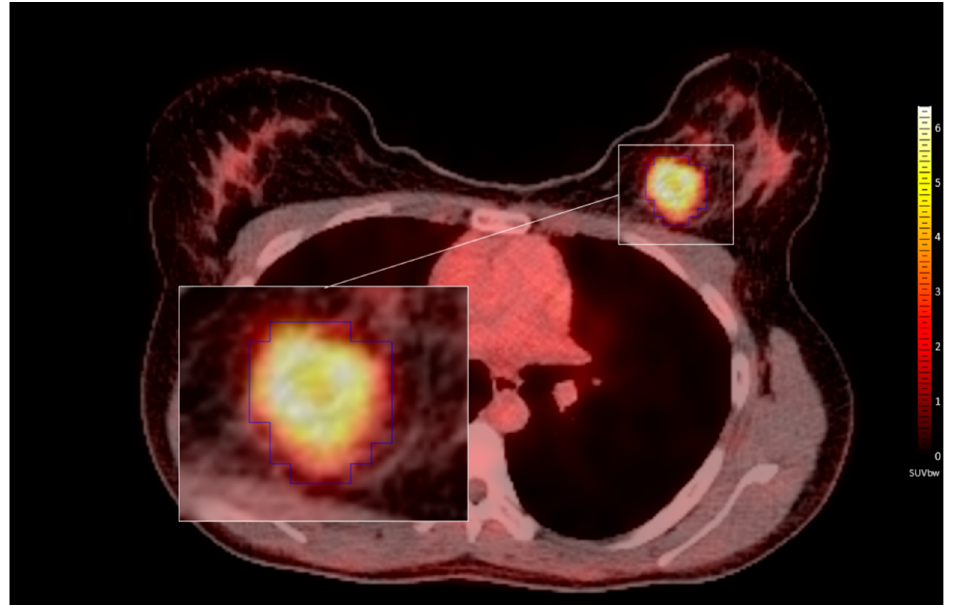
Figure 2. 18F-fluorodeoxyglucose positron emission tomography/computed tomography ([ 18 F]FDG-PET/CT) view of a breast cancer patient with semi-automatically delineated volume of interest (VOI) in the PET image. Windowing: hot iron palette with SUV body weight (SUV bw ) of 6.5 for PET and range of − 100 to 200 Hounsfield units (HU) for CT. The patient underwent imaging procedure in prone position and view is shown following the radiological convention.